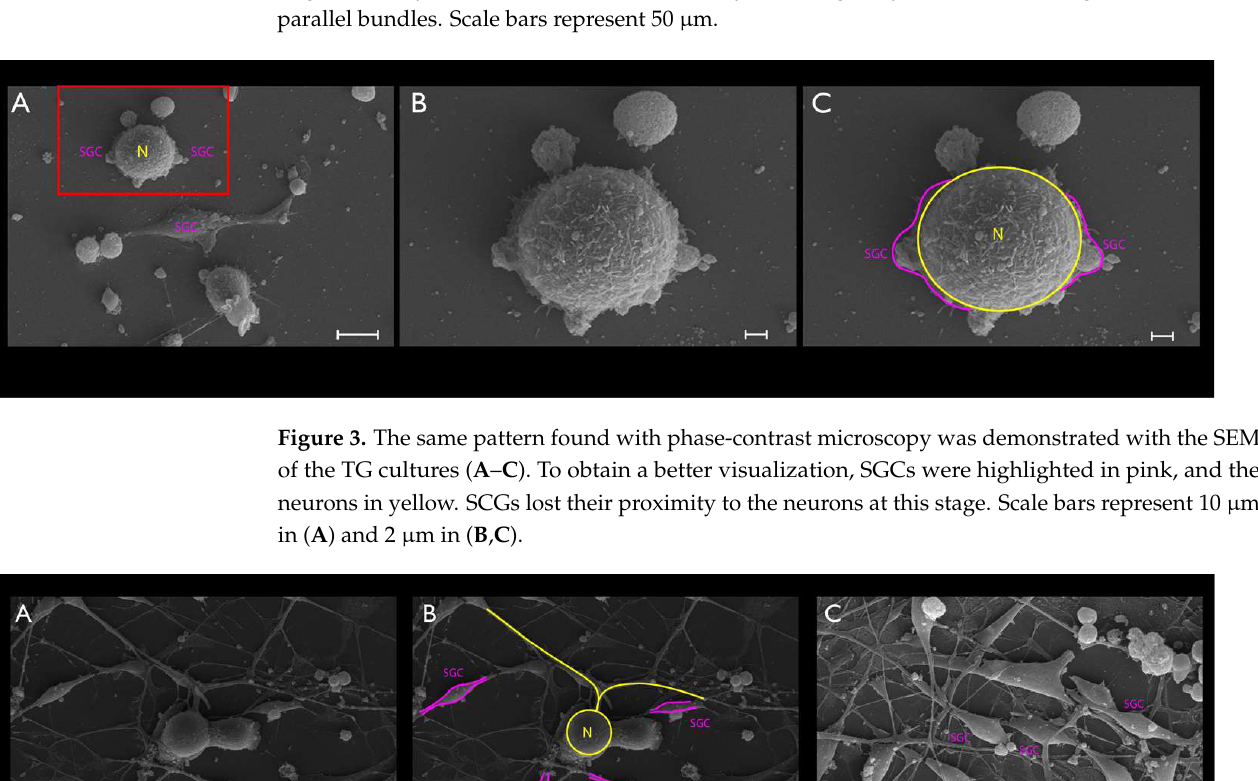
Figure 5 . The TG cultured cells after 48 h ( A – C ). Pseudounipolar neurons exhibited elongated and thin processes. SGCs migrated away from those neurons, maintaining a fusiform shape. Further- more, some of those cells were arranged in parallel bundles. Scale bars represent 10 µm in ( A , B ) and 1 µm in ( C ).